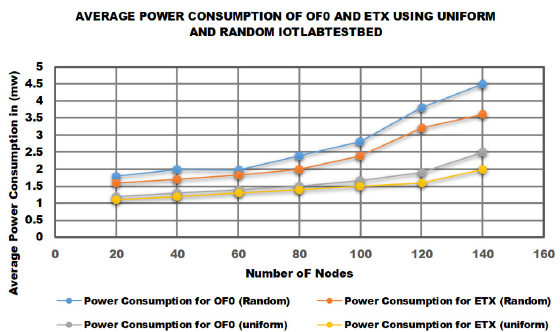
Figure 12. The total absolute power consumption for one testbed node measured over time.